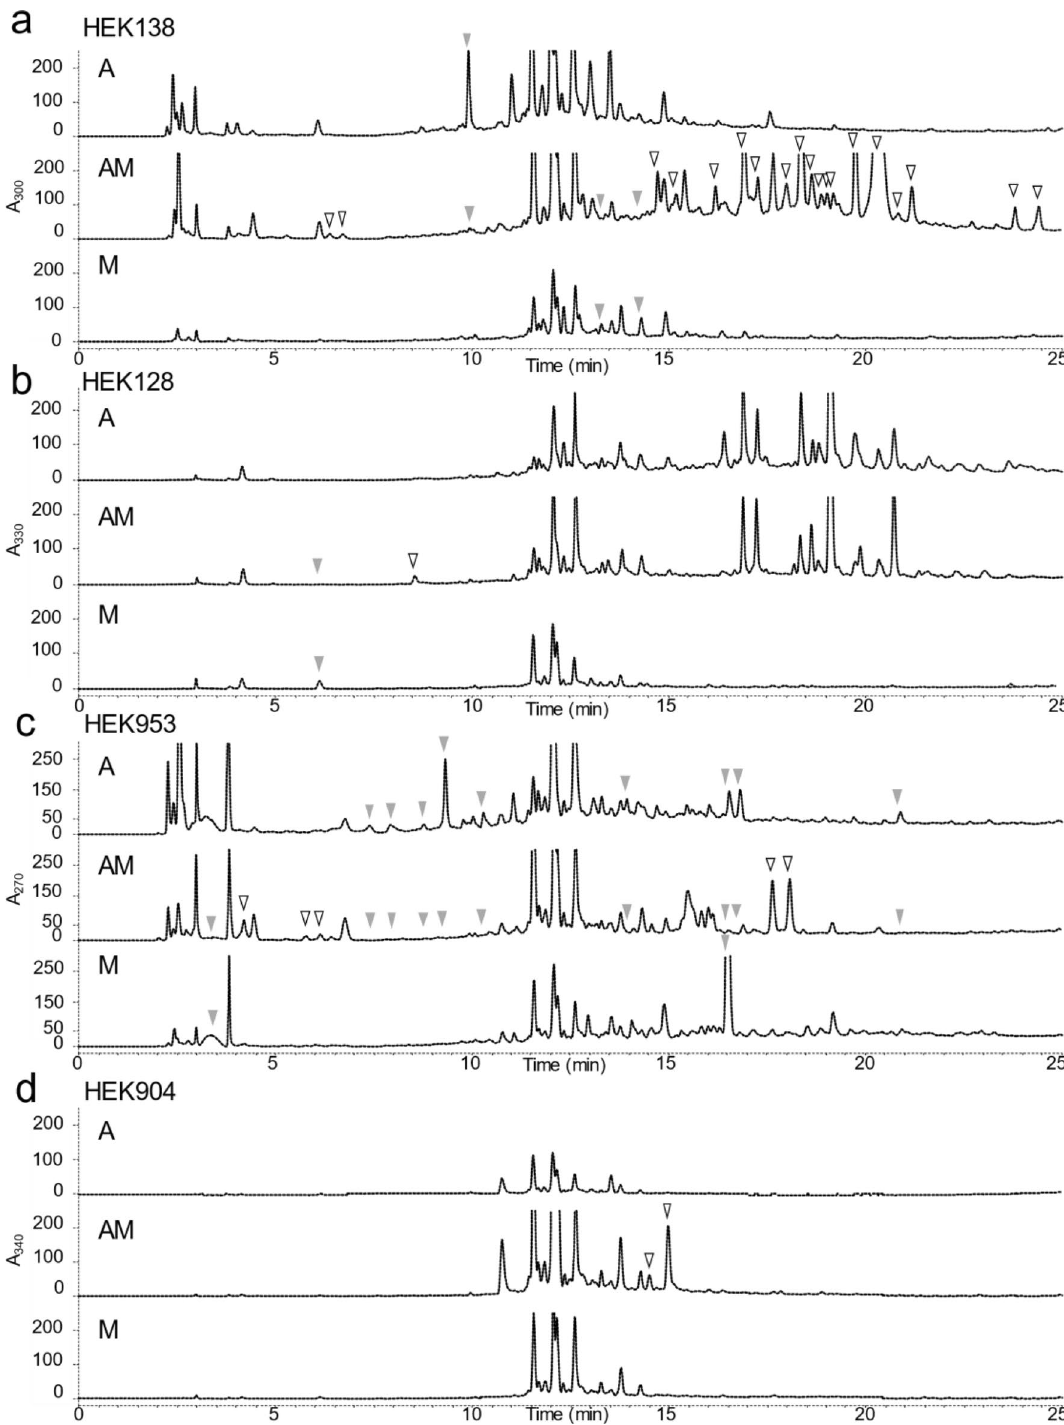
Figure 4. Metabolites analyses of naturally co-isolated bacterial pair in combined-culture using high performance liquid chromatography (HPLC). Blank arrows indicate the new peaks and gray arrows indicate the lost peaks that were observed consistently in all three replicates of combined-culture. ( a ) HPLC profiles for HEK128A and HEK128M monitored at 330 nm. ( b ) HPLC profiles for HEK138A and HEK138M monitored at 300 nm. ( c ) HPLC profiles for HEK904A and HEK904M monitored at 340 nm. ( d ) HPLC profiles for HEK953A and HEK953M monitored at 270 nm. The wavelengths monitored were selected to show the clear differences between combined-culture and